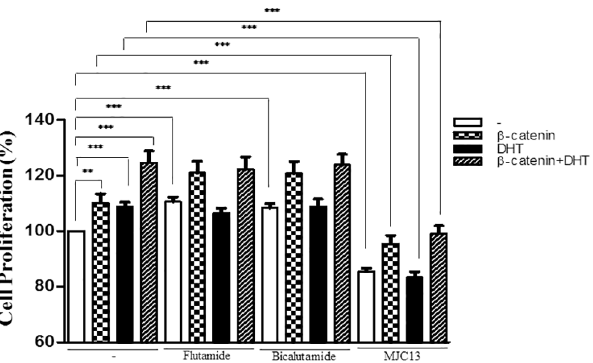
Fig 10. MJC13 inhibits β -catenin-induced LNCaP cell proliferation. LNCaP cells were infected with adenovirus expressing β -catenin (Ad- β -catenin) or null adenovirus (Ad-Null) at multiplicity of infection = 50, and maintained in normal media with steroid depleted serum. Cells were treated +/- DHT (1nM) +/- 1 μ M Flutamide, Bicalutamide or 30 μ M MJC13 for 24 h. The absorbance was measured using an ELISA reader at a wavelength of 450 nm. All data are representative of at least three independent experiments with similar results. Values represent the mean ± SD of triplicate samples. *** P < 0.001; ** P < 0.01; * P < 0.05. The shading scheme is as follows: White bars, adenovirus control, squared bars, Ad- β -catenin, black bars, adenovirus control + DHT, striped bars, Ad- β -catenin +